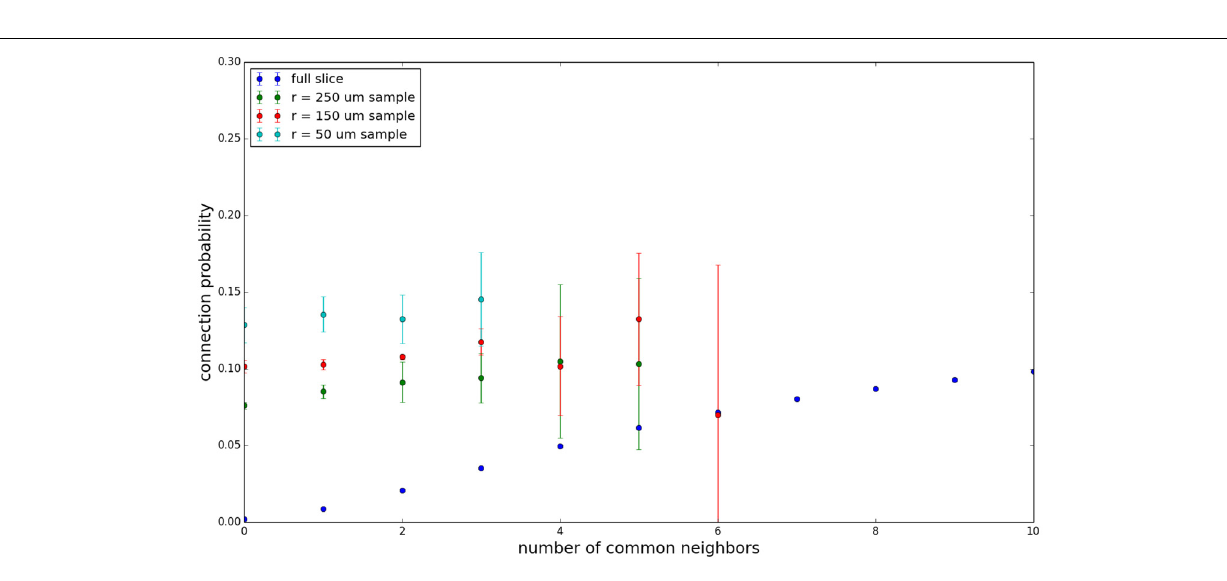
300 µ m slice in Figures 10 , 11 . Again, sliced and sampled behav- ior does not vary much between slice sizes; only sample